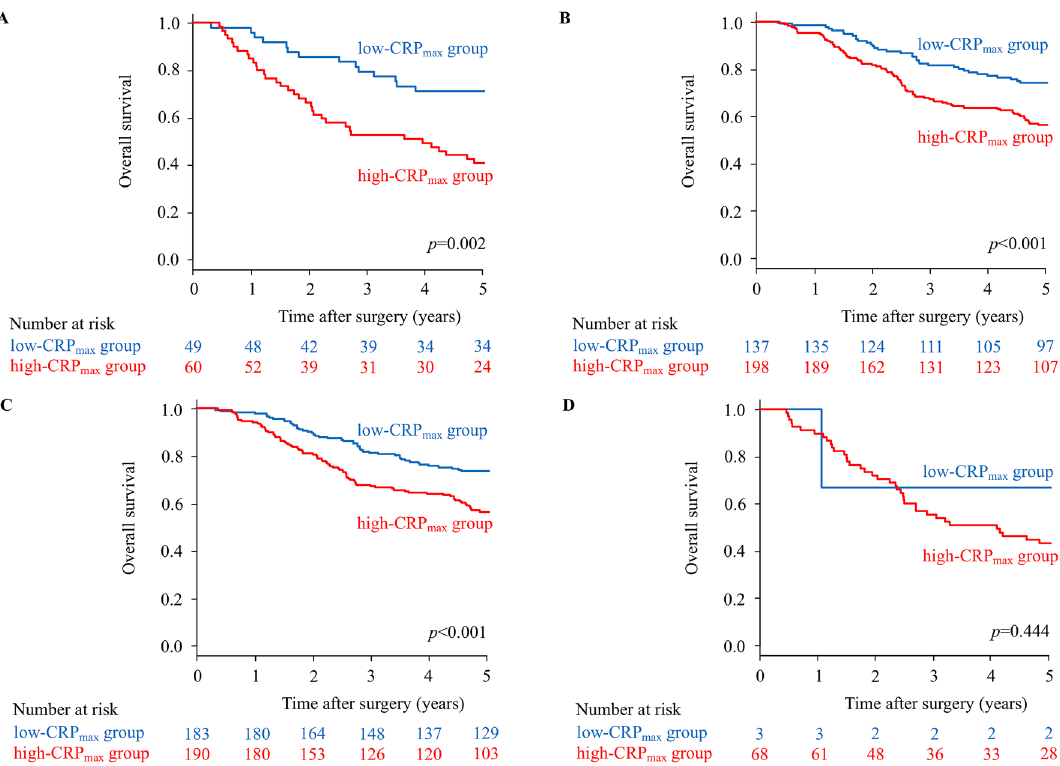
Figure 3. Kaplan–Meier survival curves of overall survival (OS) according to CRP max in patients without adjuvant chemotherapy ( A , p = 0.002), in patients with adjuvant chemotherapy ( B , p < 0.001), in patients without postoperative infectious complications ( C , p < 0.001), in patients with postoperative infectious complications ( D , p =